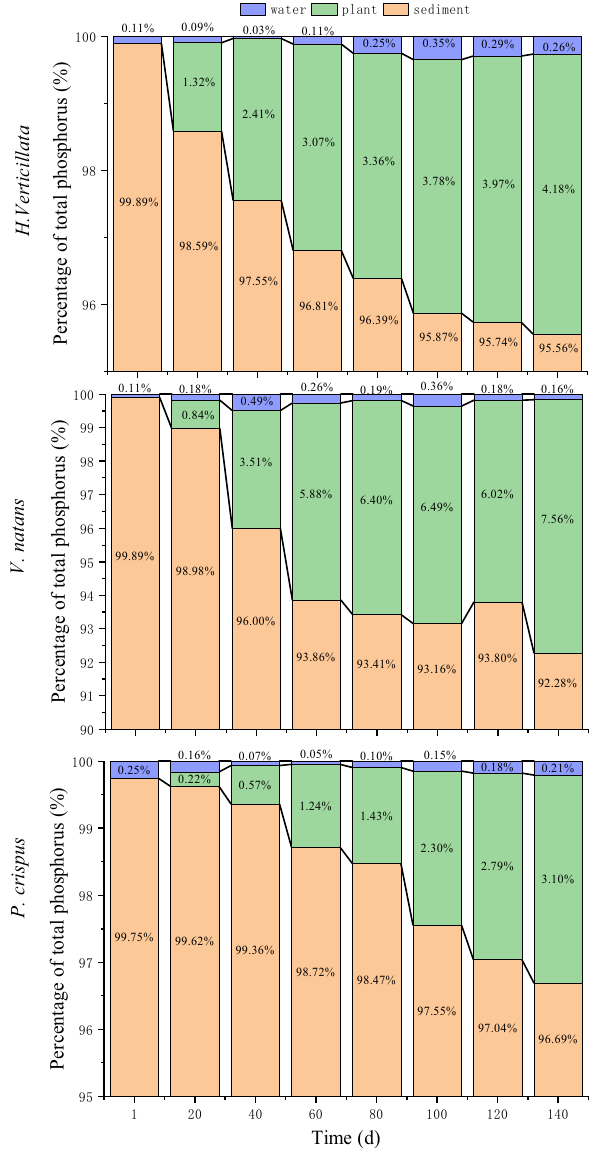
Fig. 6 Percentage of phosphorus in sediment-submerged macro- phytes water. The Y axes are cut off and do not start at zero